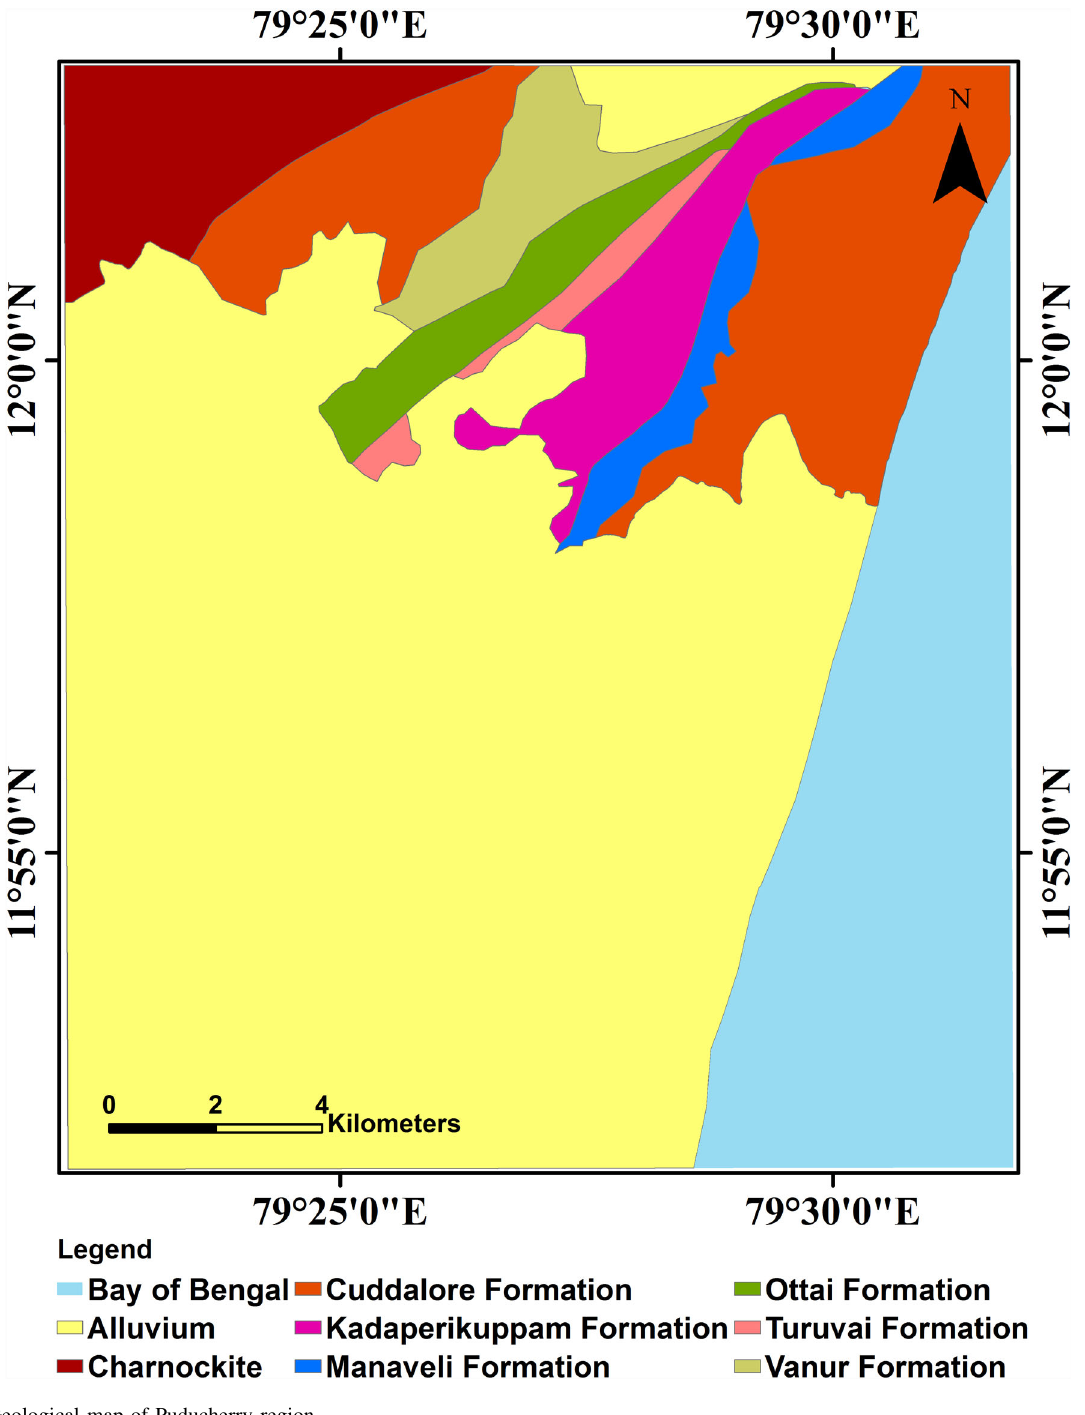
Fig. 2 Geological map of Puducherry